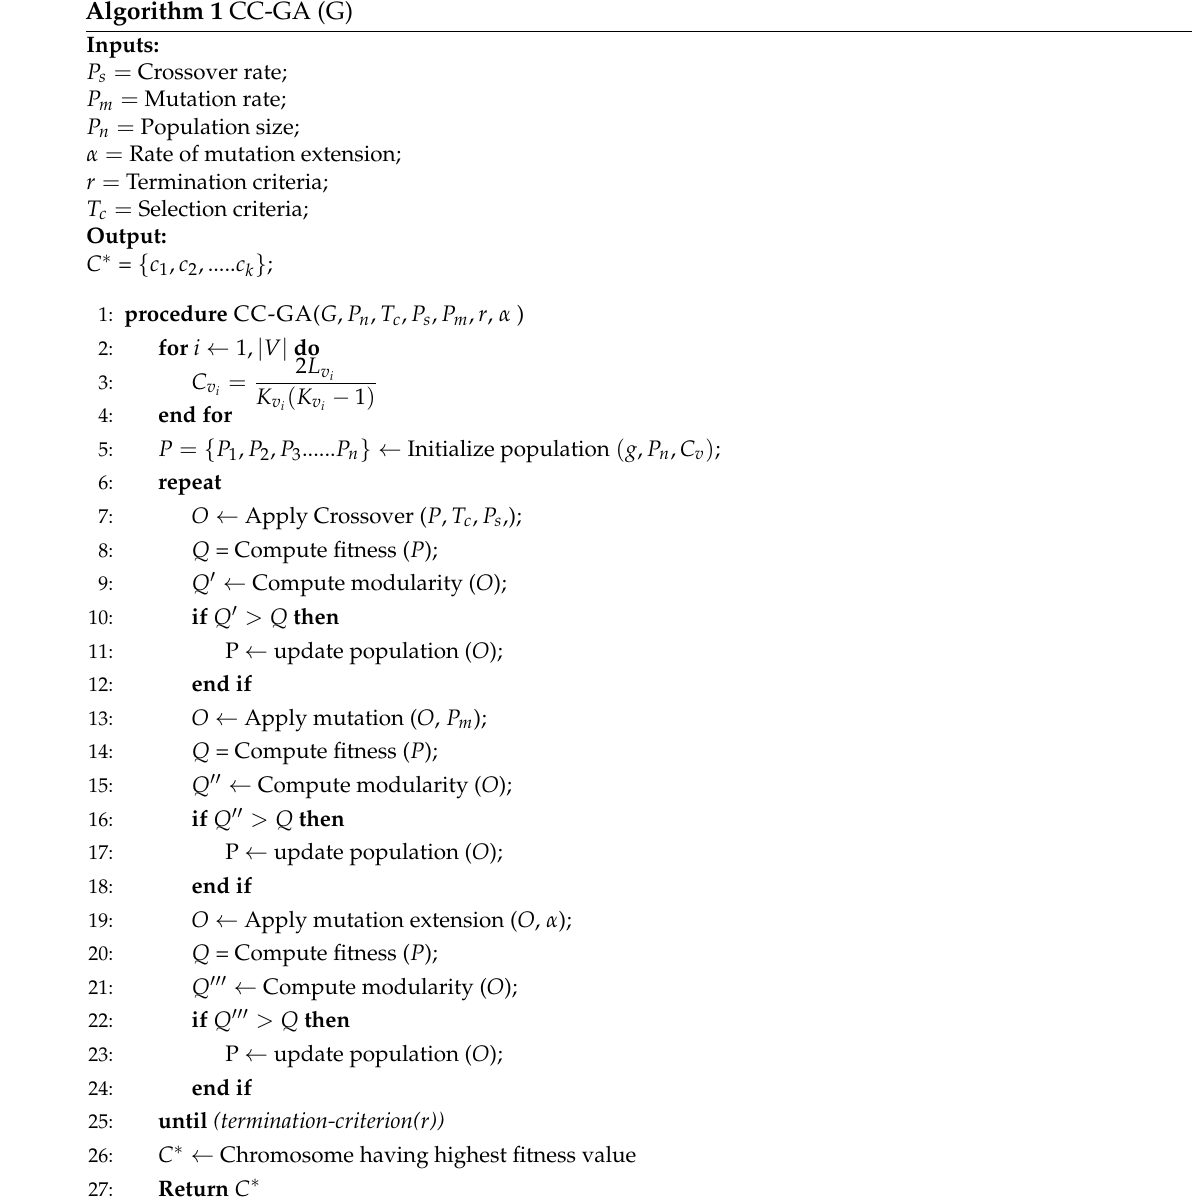
Algorithm 1 CC-GA